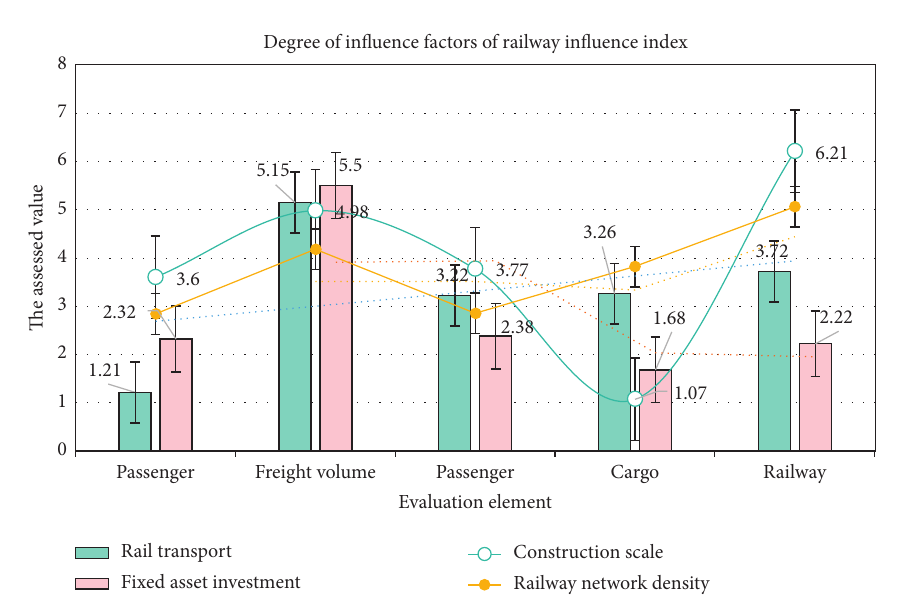
Figure 8: Degree of influence factors of railway influence